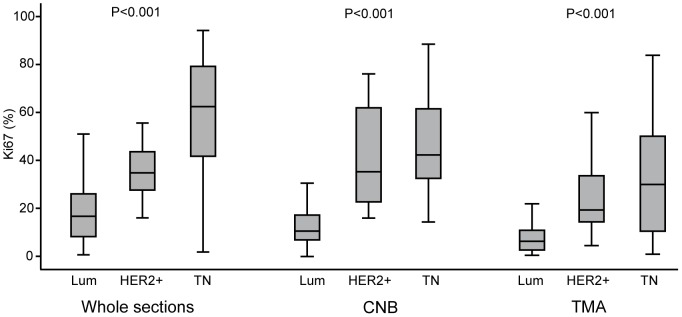
Box plots of tumor cell proliferation by Ki67 expression according to breast cancer molecular subgroups in different specimen categories.Horizontal lines inside the boxes represent the median value; box limits indicate the 25th and 75th percentiles; whiskers extend 1.5 times the interquartile range from the 25th and 75th percentiles.